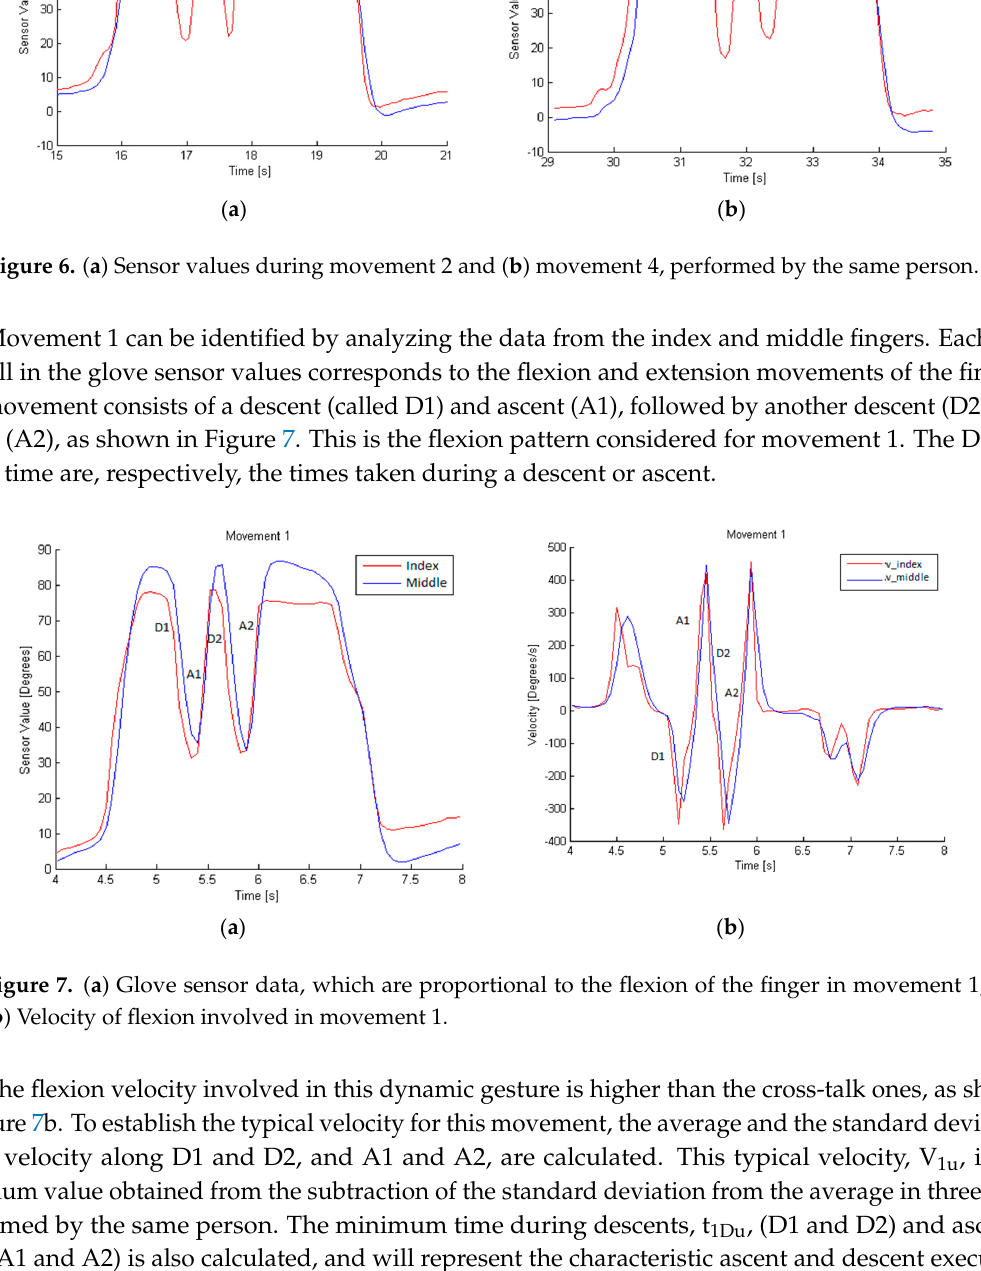
Table 2. Characterization of defined movements.